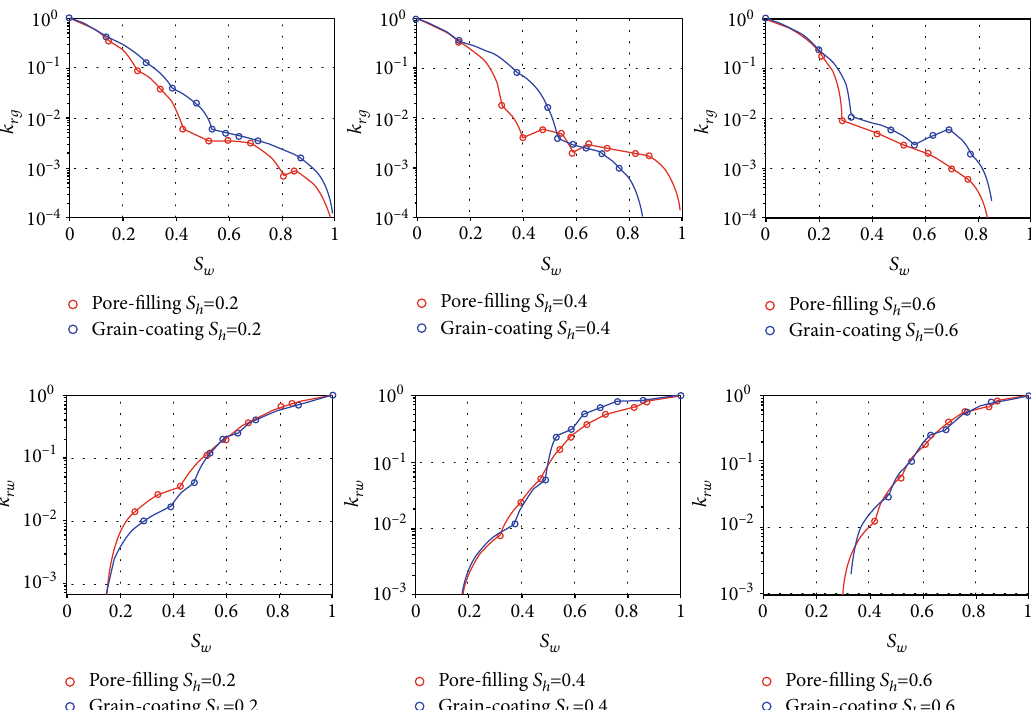
Figure 13: Comparison of gas/water relative permeability for hydrate pore habit of grain-coating and pore- fi fi gures, k = 0 : 01 is an important point that corresponds to rg water saturation S near the dividing point (Section 3.3). w